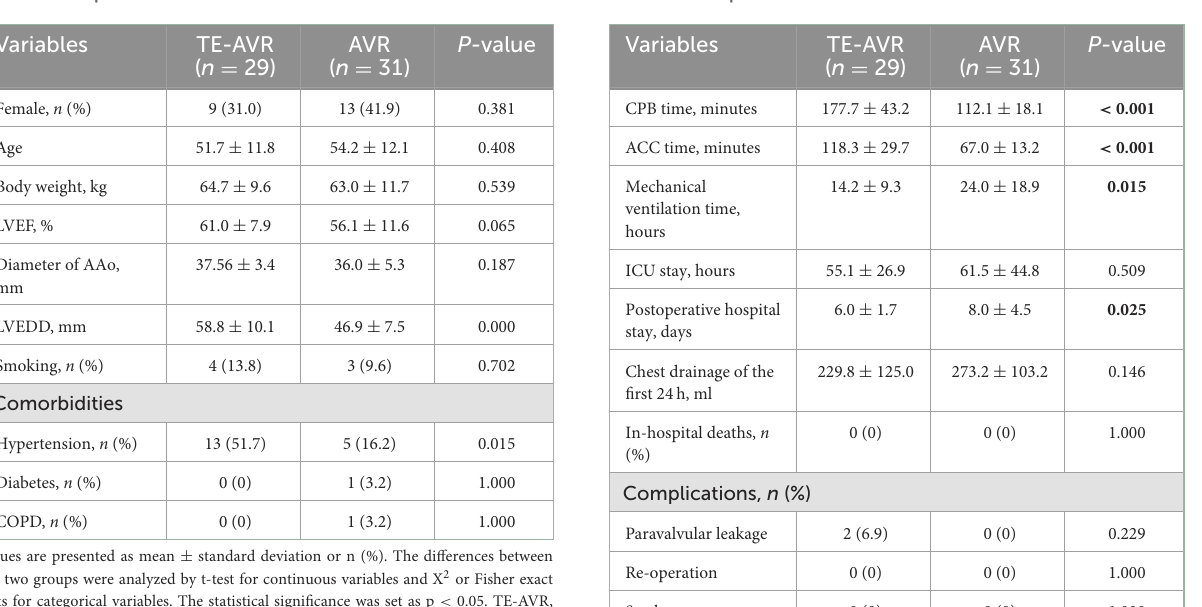
TABLE 1 Preoperative baseline data. TABLE 2 Perioperative